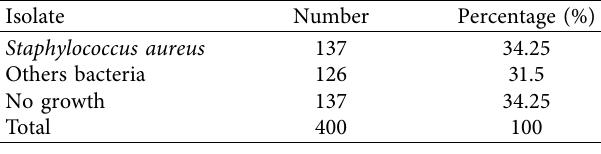
Figure 3: Agarose gel electrophoresis for PCR product of en- terotoxin B gene (165bp) and 16s rRNA (756bp). Lane 1, DNA ladder 50bp. Lane 2 shows a typical band of the positive control S . aureus enterotoxin B seb gene. Lane 3 shows a positive enterotoxin B gene product of S . aureus isolated from cheese samples (sample 16). Bands 4, 5, and 6 show a positive sample for 16s rRNA gene (isolates 16, 17, and